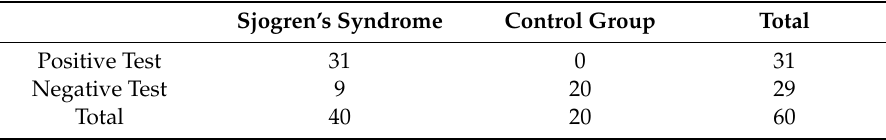
Table 2. Diagnostic accuracy of the salivary lymphocytes